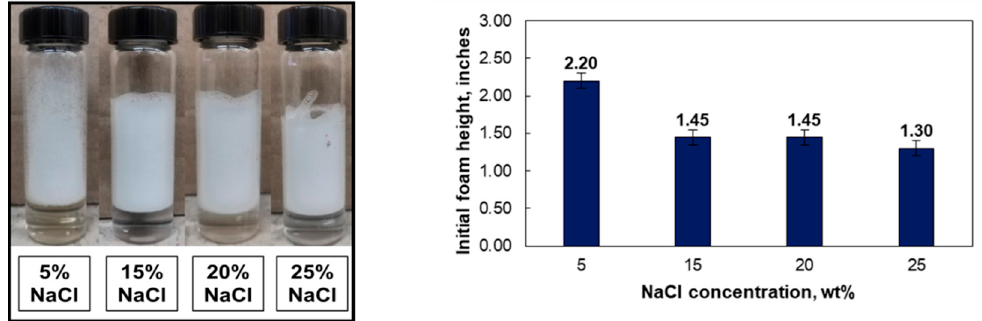
Figure 8. Effect of salinity on the initial foamability at pH 6.5, 0.5 wt% surfactant, and 77 °F (25 °C).